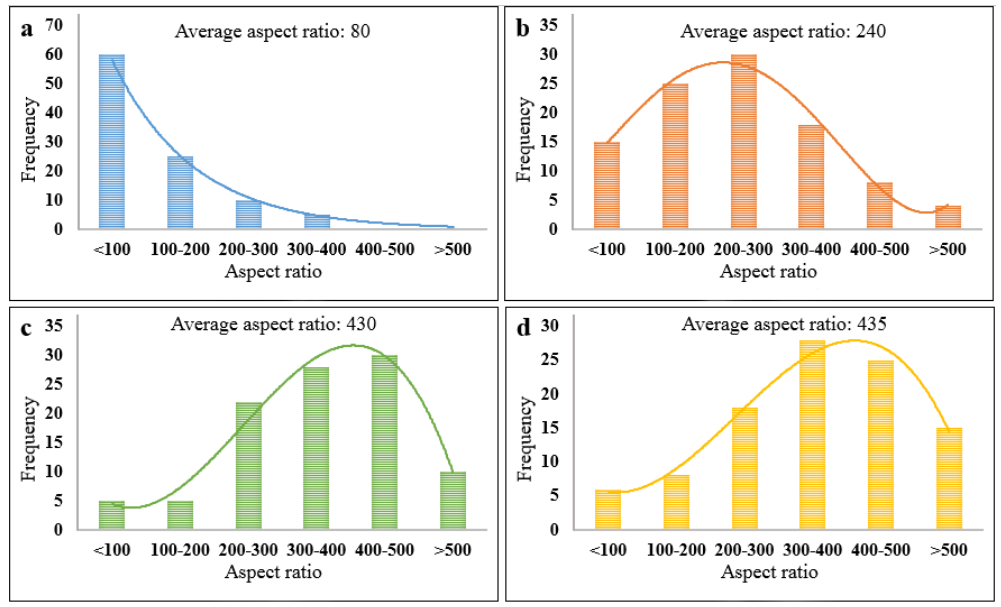
Figure 3. Influence of CTAB on the aspect ratios of α-CaSO 4 ·0.5H 2 O whiskers CTAB (mol·L −1 ): ( a ) 0; ( b ) 1.0 × 10 −4 ; ( c ) 9.2 × 10 −4 ; ( d ) 1.5 × 10 −3 .